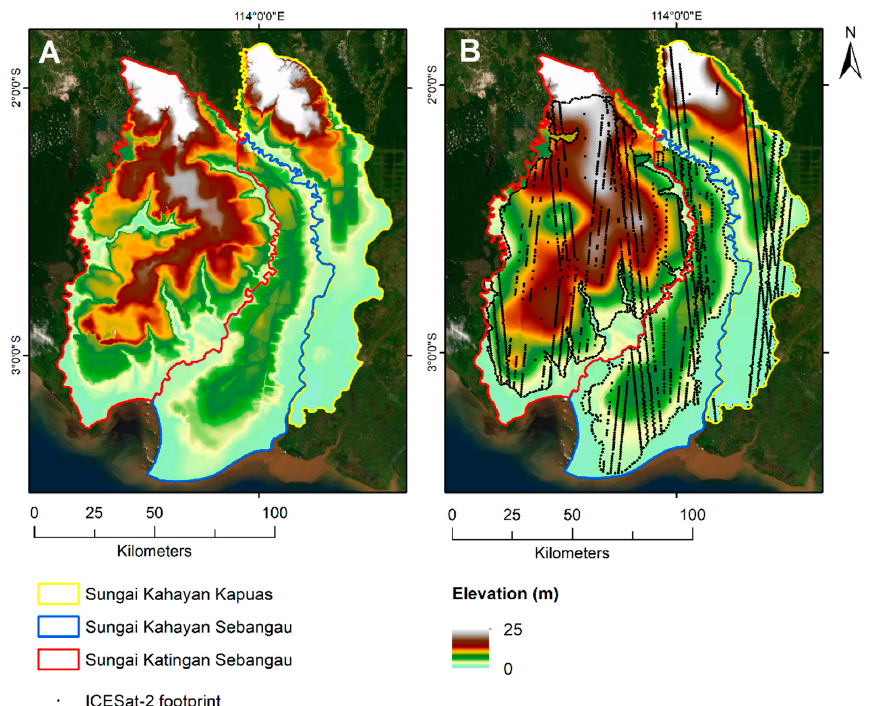
Figure 6. Comparison of the DTM of three PHU. A shows the WorldDEM DTM; the B shows the peat dome surface model obtained by interpolating all available ICESat-2 footprint DTM measurements. ICESat-2 footprints used for the interpolation are shown as black circles.